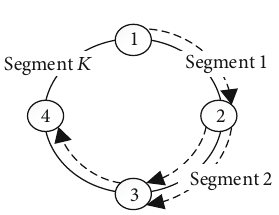
Figure 1: Relationship between the total cargo volume of each